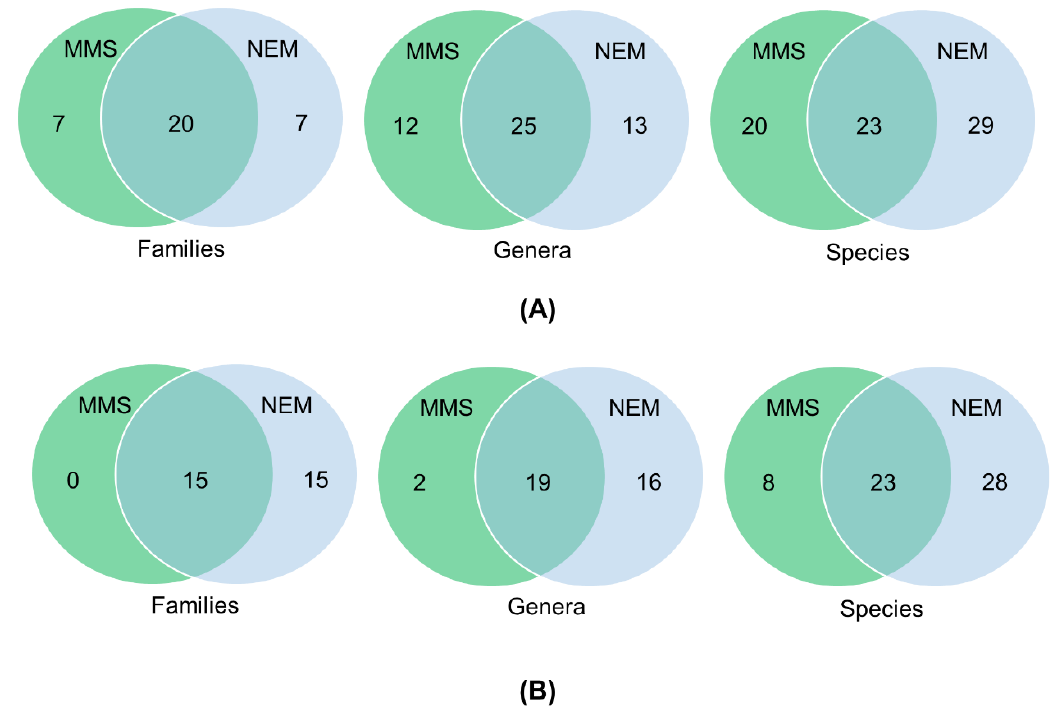
Figure 2. Venn diagrams showing the number of nematode taxa detected in soil ( A ) and root samples ( B ) by the MMS (MMSF/MMSR) and NEM (Nemf/18Sr2b) primer sets.